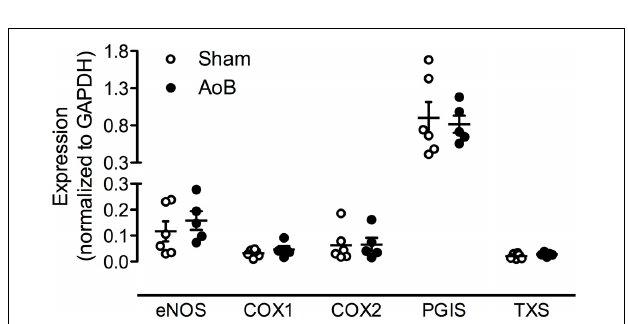
FIGURE 8 | mRNA expression of eNOS, cyclooxygenase (COX) 1 and COX2, prostacycline synthase (PGIS) and TxS in coronary small arteries from Sham-operated swine and swine with AoB. mRNA expression was normalized to expression of GAPDH.